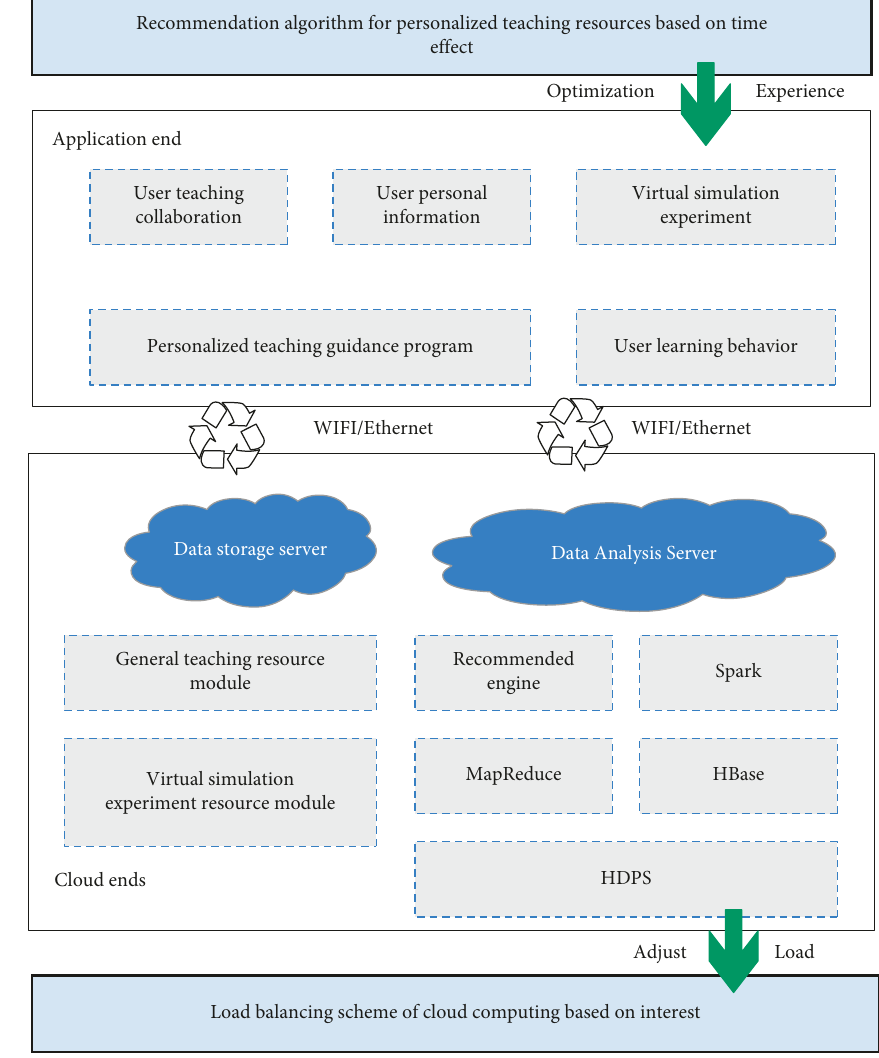
Figure 3: Architecture diagram of virtual foreign language teaching